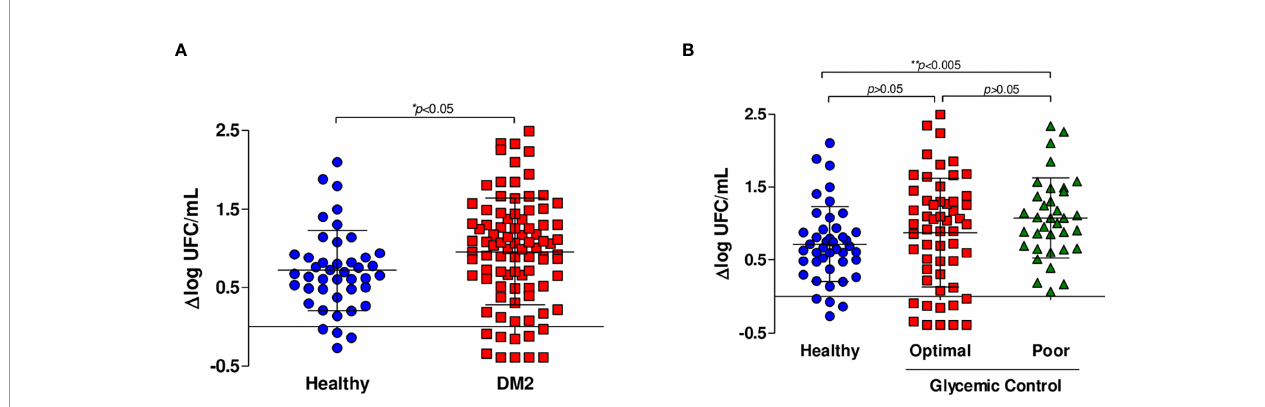
FIGURE 1 | In vitro growth inhibition of M. tuberculosis H37Rv. Whole blood inhibition assays were carried out in healthy subjects (n=44), subjects with optimal glycemic control (HbA1c<7) (n=54) and subjects with poor glycemic control (Hba1c>8) (n=35). (A) Comparison of the capacity to inhibit mycobacterial growth of whole blood from healthy subjects (n=44) and patients living with DM2 (n=89). (B) Comparison of the capacity to inhibit mycobacterial growth of whole blood from healthy subjects and patients with DM2 with optimal and poor glycemic control.